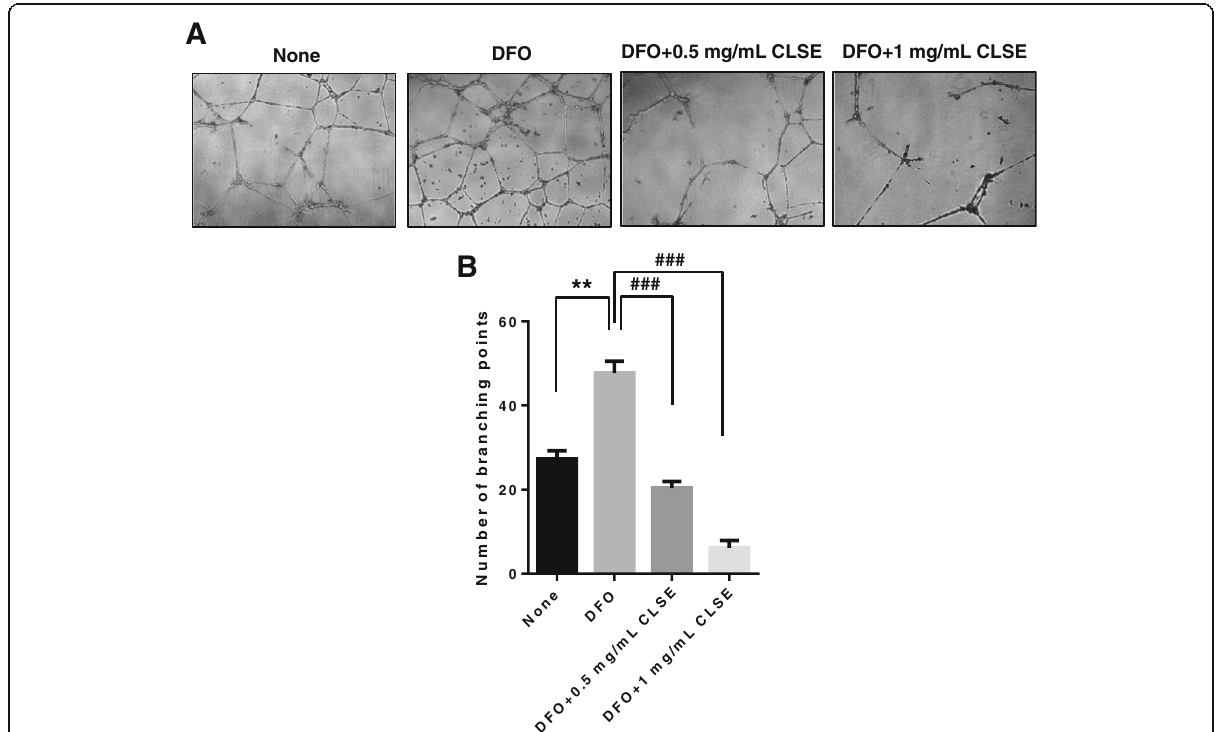
Fig. 5 Effect of CLSE on HUVECs capillary tube formation. a . After HUVECs were seeded in matrigel-coated plates and incubated with conditioned media from HCT116 cells treated with DFO (100 μ M) and CLSE (0.5, 1 mg/mL) for 24 h. Representative images showing HUVEC tube formation following treatment with conditioned media collected from CLSE-treated HCT116 cells (magnification: ×40). b . Number of branching points per unit area following treatment with conditioned media. ** p < 0.01 versus untreated control group. ### p < 0.001 versus DFO-only group. Data are mean ± SD ( n = 3). CLSE, Coix lacryma-jobi var. ma-yuen Strapt sprout extract; HUVECs, human umbilical vein endothelial cells; SD, standard